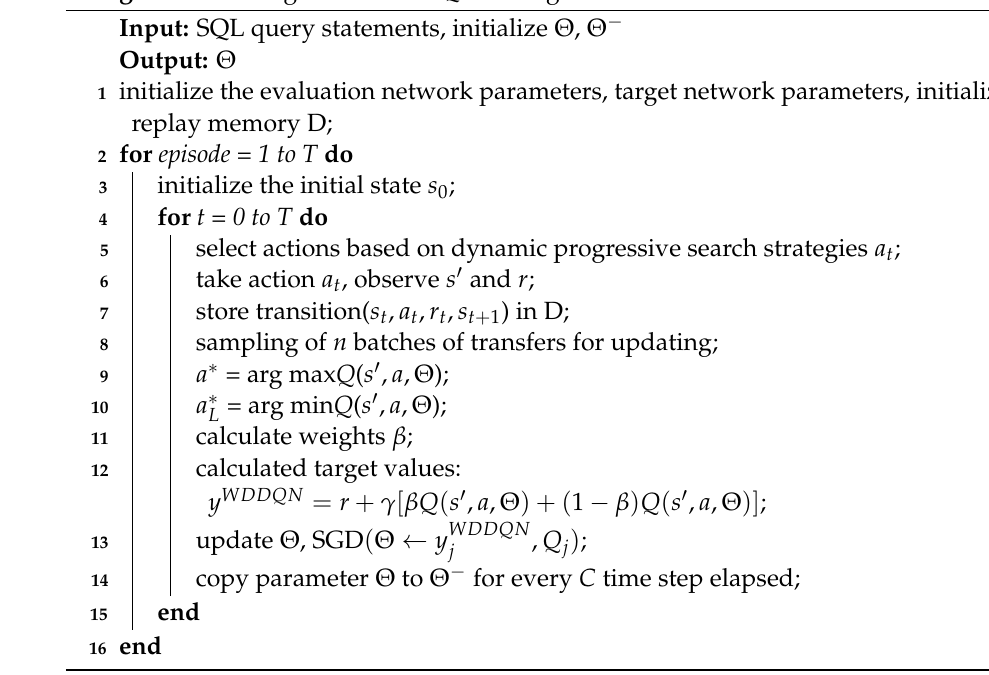
Algorithm 1: Weighted Double